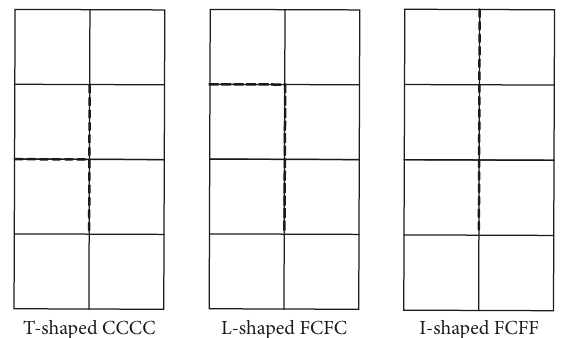
Figure 6: A rectangular thin plate divided uniformly into 8 square elements and the serial numbers of each element and side.